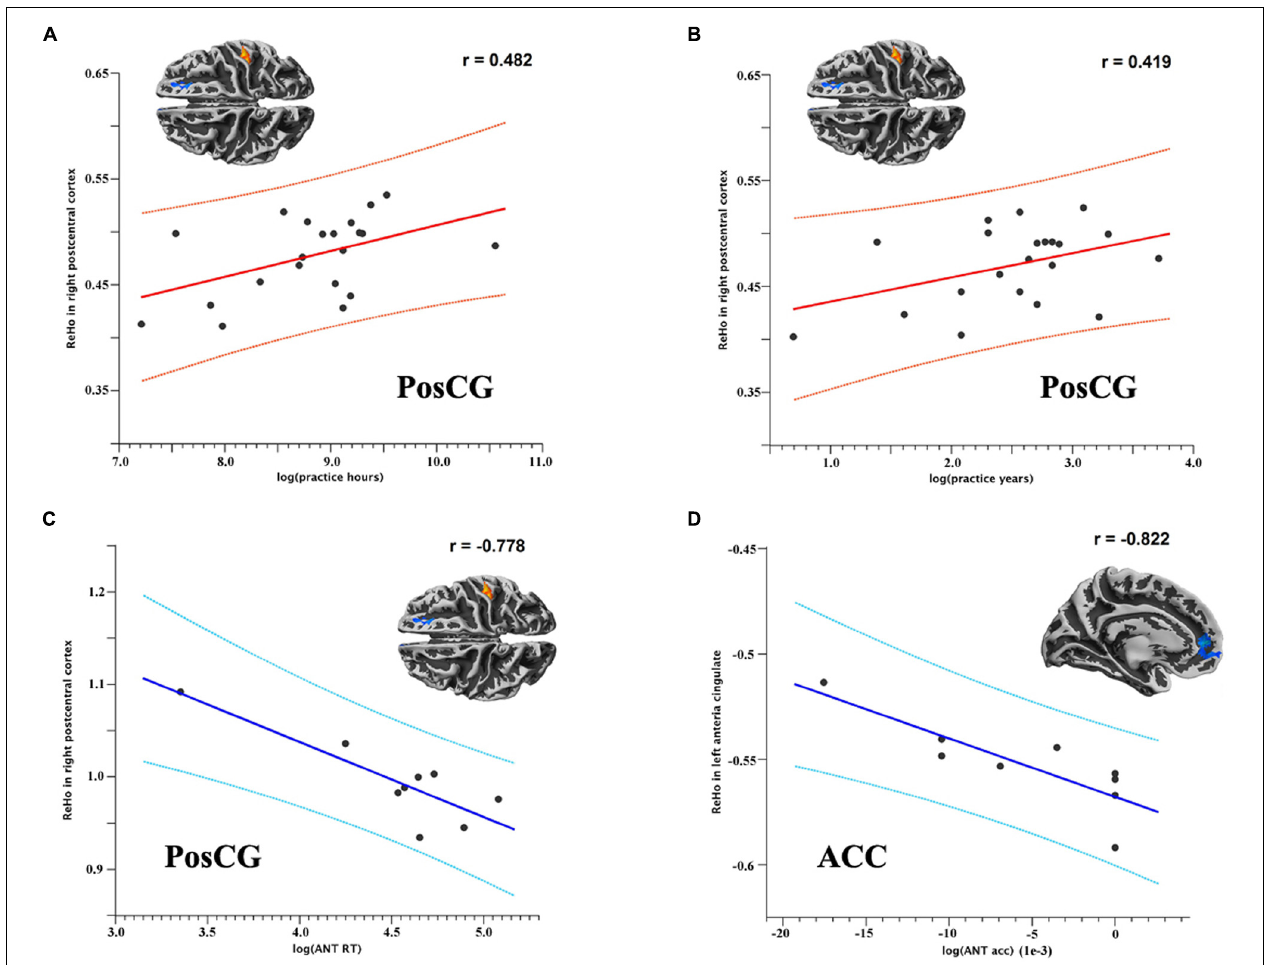
FIGURE 3 | Scatter plots (A,B) show the (marginally) significant correlations between 2dReHo in the right PosCG andTCC practice hours and years, respectively. Scatter plots (C,D) show the (marginally)